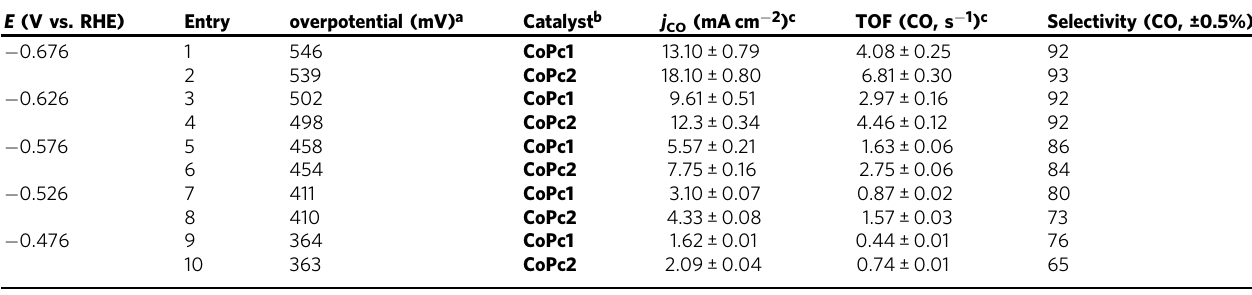
The uncertainties represent standard errors obtained from four measurements